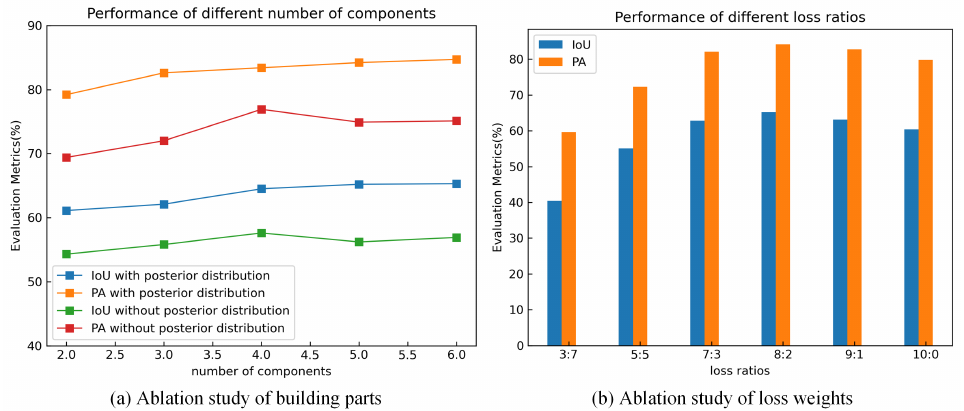
Figure 4. Ablation study of Capsule–Encoder–Decoder. ( a ) Ablation study about different numbers of building parts, ( b ) Ablation study about different loss weights.